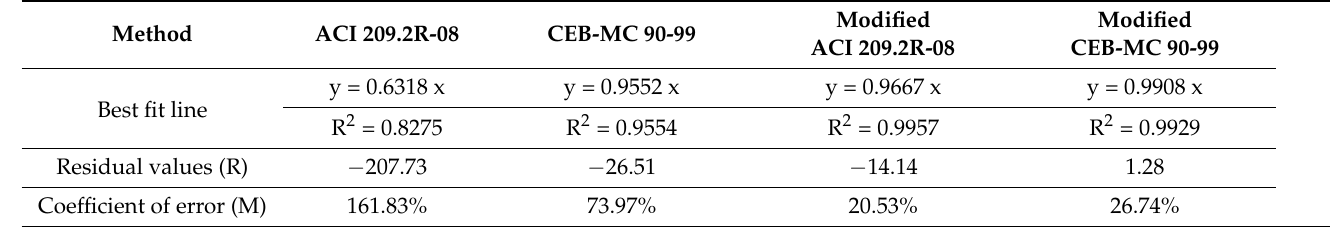
Figure 11. Evaluation of the modified ACI 209.2R-08 ( a ) and the modified CEB-MC 90-99 ( b ) models by residual analysis. Table 4. Summary of quantitative evaluation of the modified and original prediction models.